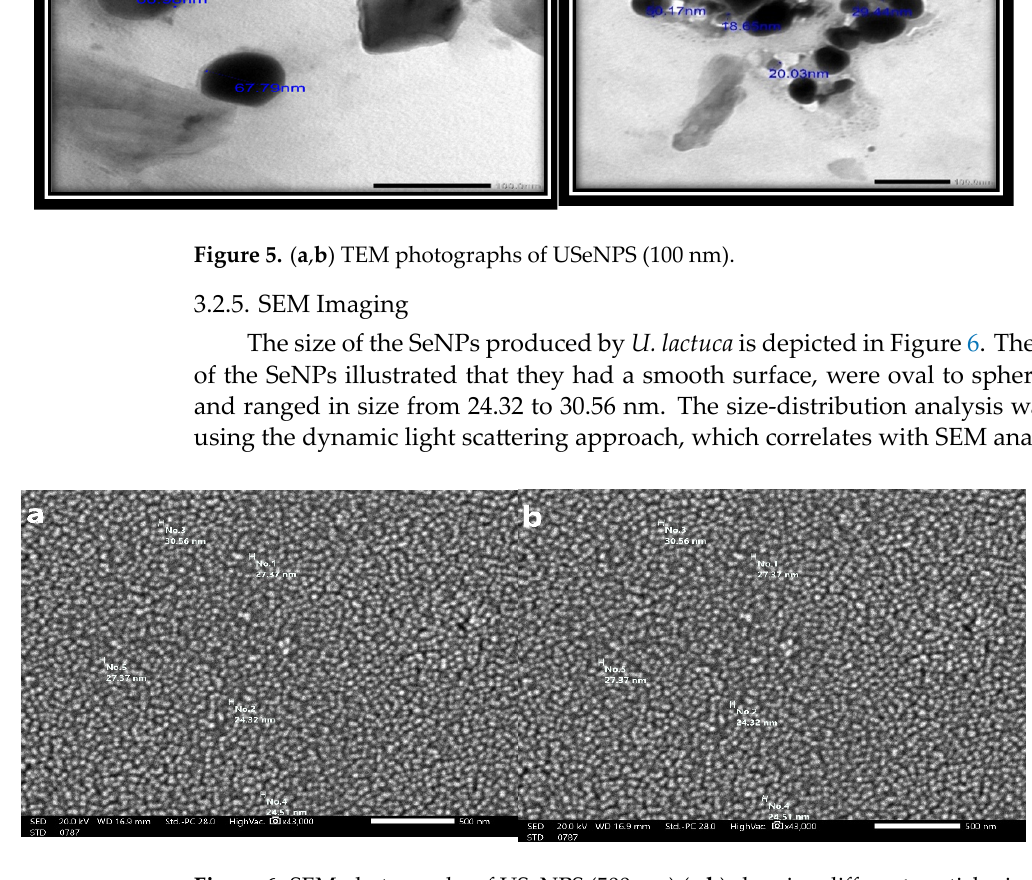
Figure 4. XRD spectrum of UseNPs.